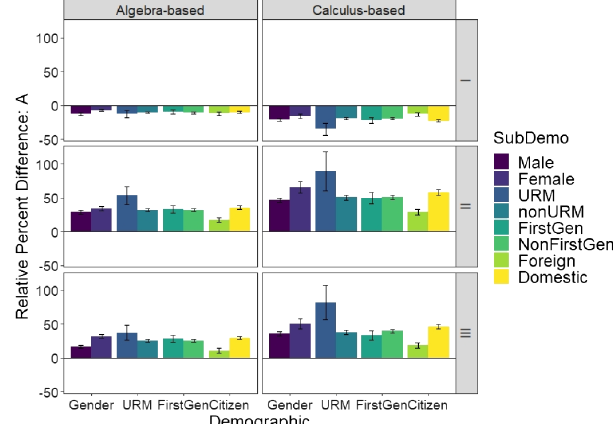
FIG. 5. Relative percent differences in A ’ s between model 0 and models I, II, or III, by demographic group and course. For example, if model II were used instead of model 0 in the algebra- based course, about 50% more URMs and about 30% more non- URMS would have received an